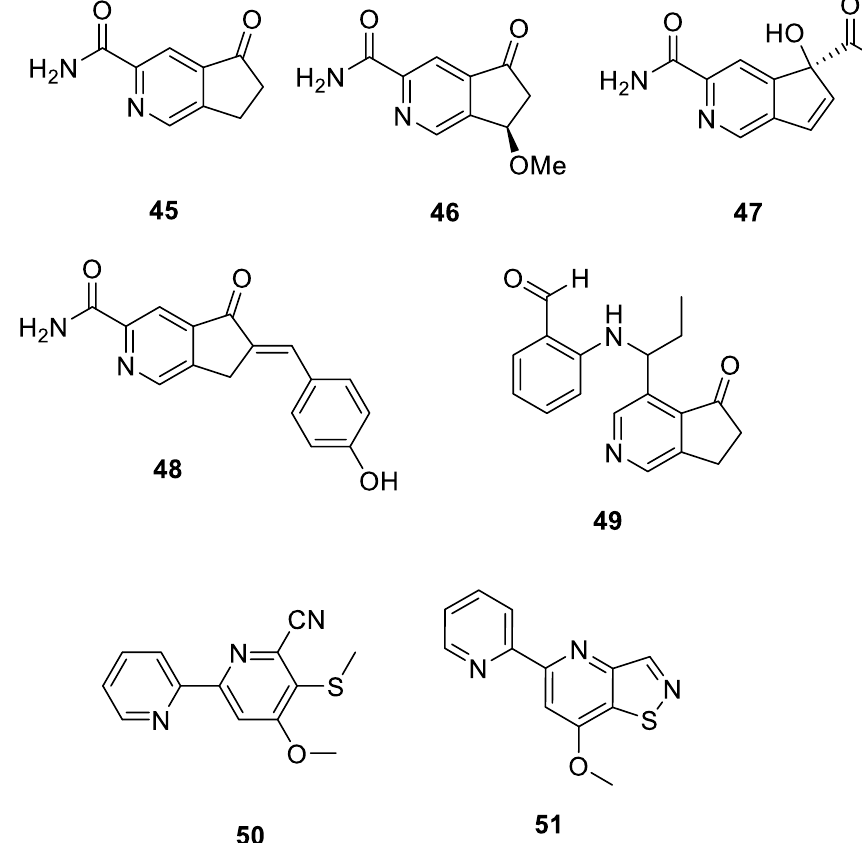
Figure 7. Chemical structures of compounds 45 − 51 from lichen-associated actinomycetota.